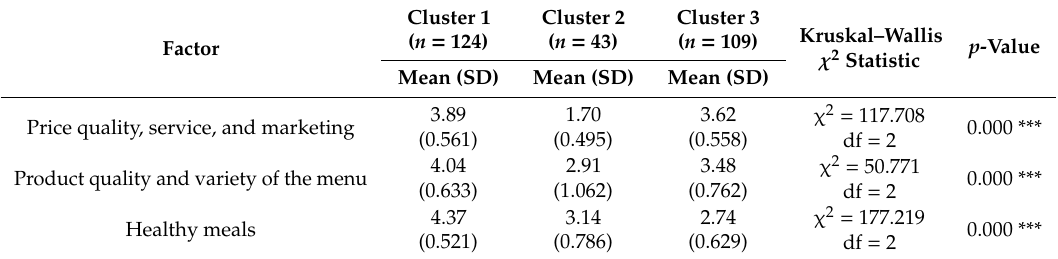
Table 6. Mean of